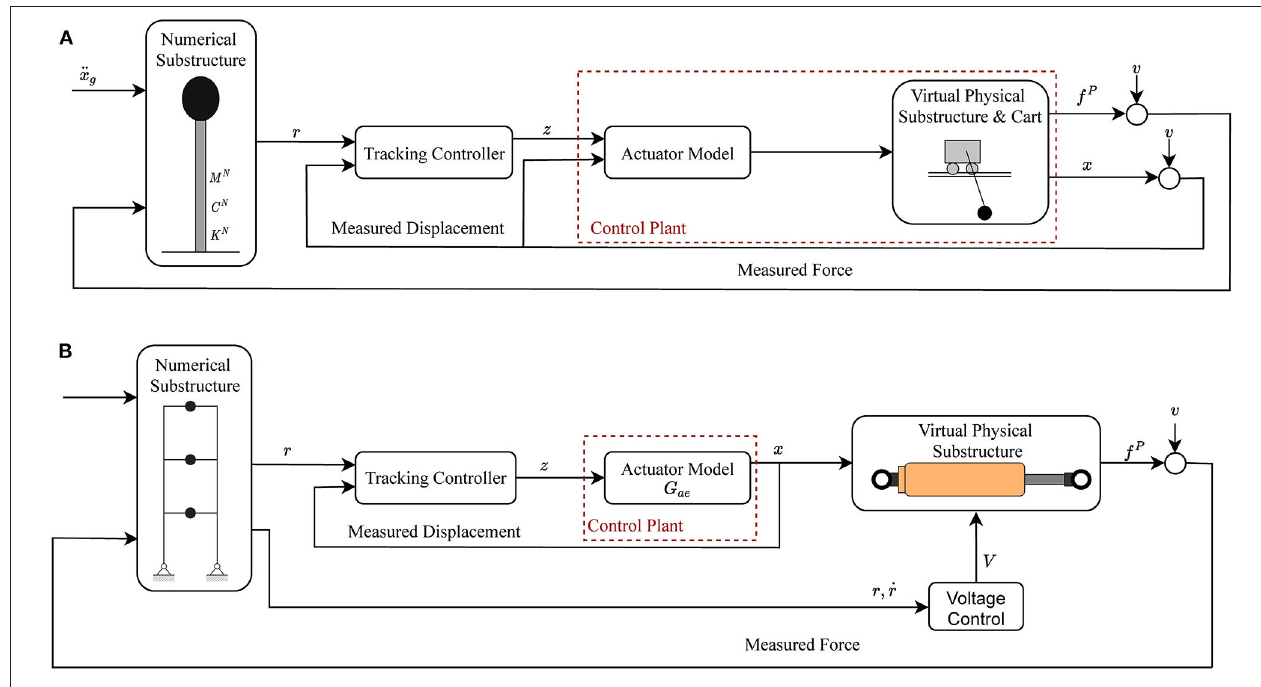
FIGURE 5 | Block diagrams of hybrid models: (A) CS1, (B) CS2.